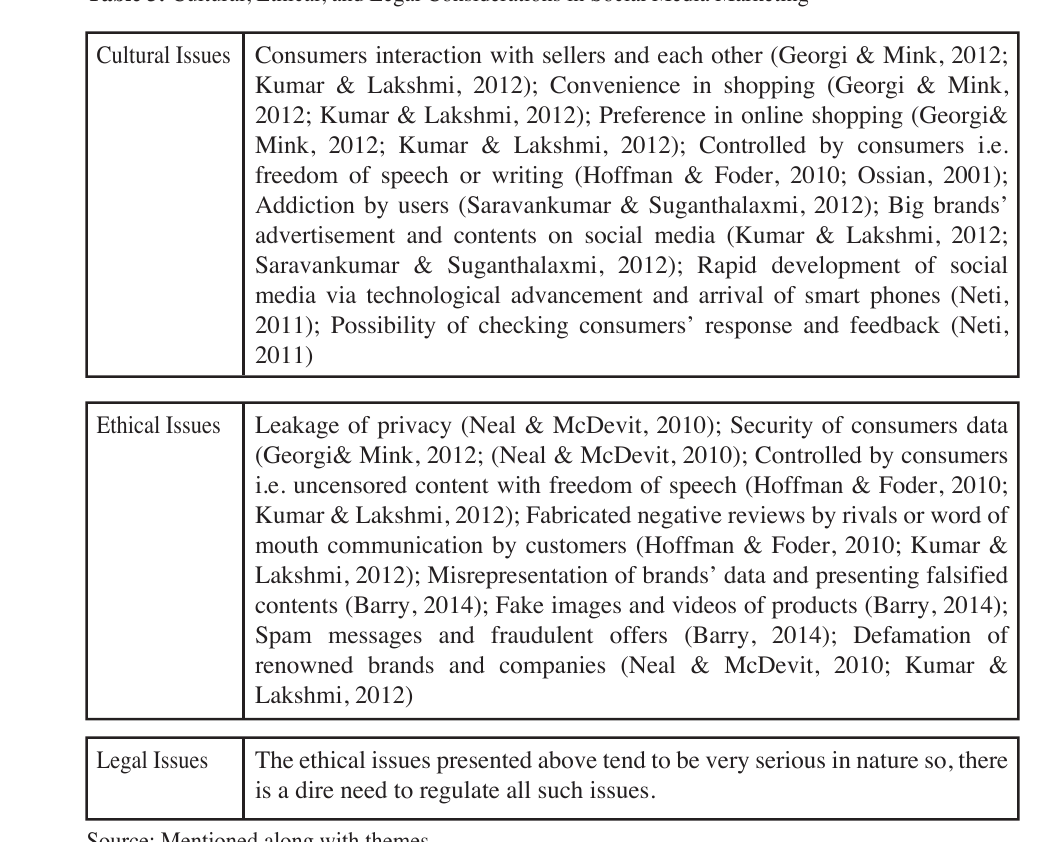
Table 3: Cultural, Ethical, and Legal Considerations in Social Media